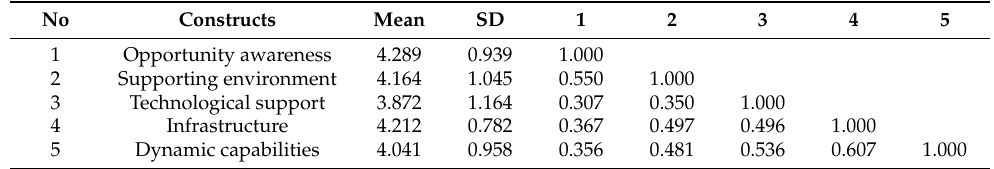
Table 2. Mean, standardized deviations, and correlations of